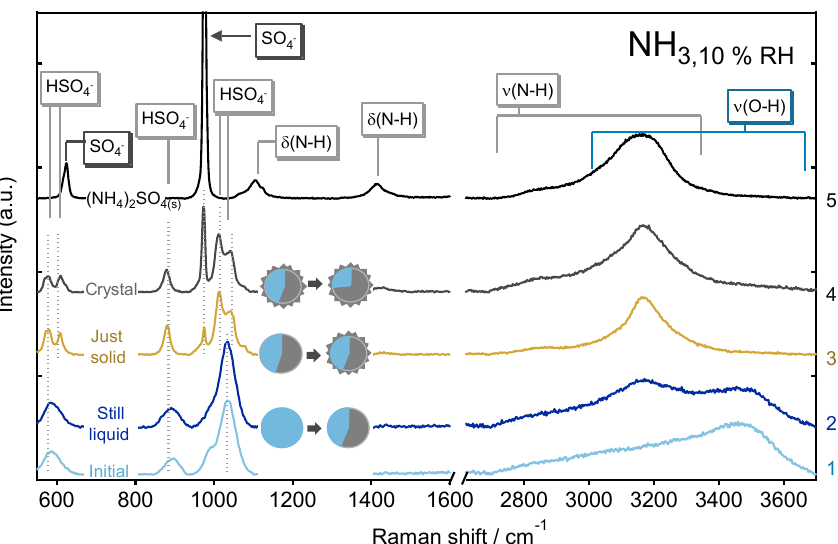
Figure 6. Raman spectra of selected particles representing different phase states during uptake of NH 3 into H 2 SO 4 at 10% RH. A spectrum of crystalline (NH 4 ) 2 SO 4 is added for reference. Sketches indicate the cation composition range (as inferred from IC measurements) of particles when the spectra were recorded; grey denotes NH 4 and blue denotes H 3 O + (HSO − 4